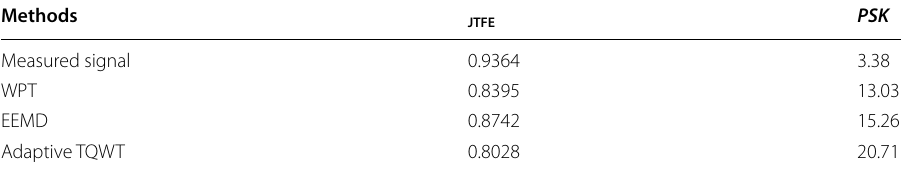
The results of simulation experiments show that the new method is superior to the WPT decomposition and EEMD method in terms of noise removal and transient fea- ture extraction.